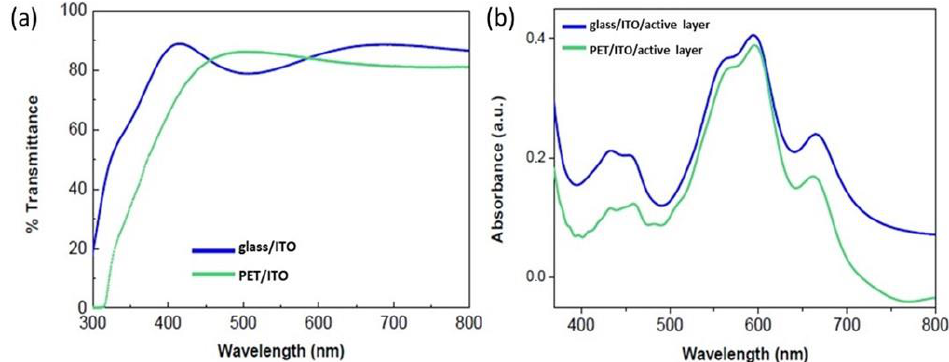
Figure 2. ( a ) Transmission spectra of commercial ITO-glass and ITO-PET substrates employed in this work and ( b ) UV-Visible spectra of a DPP(TBFu) 2 :PC 61 BM photoactive layer fabricated onto these two substrates.